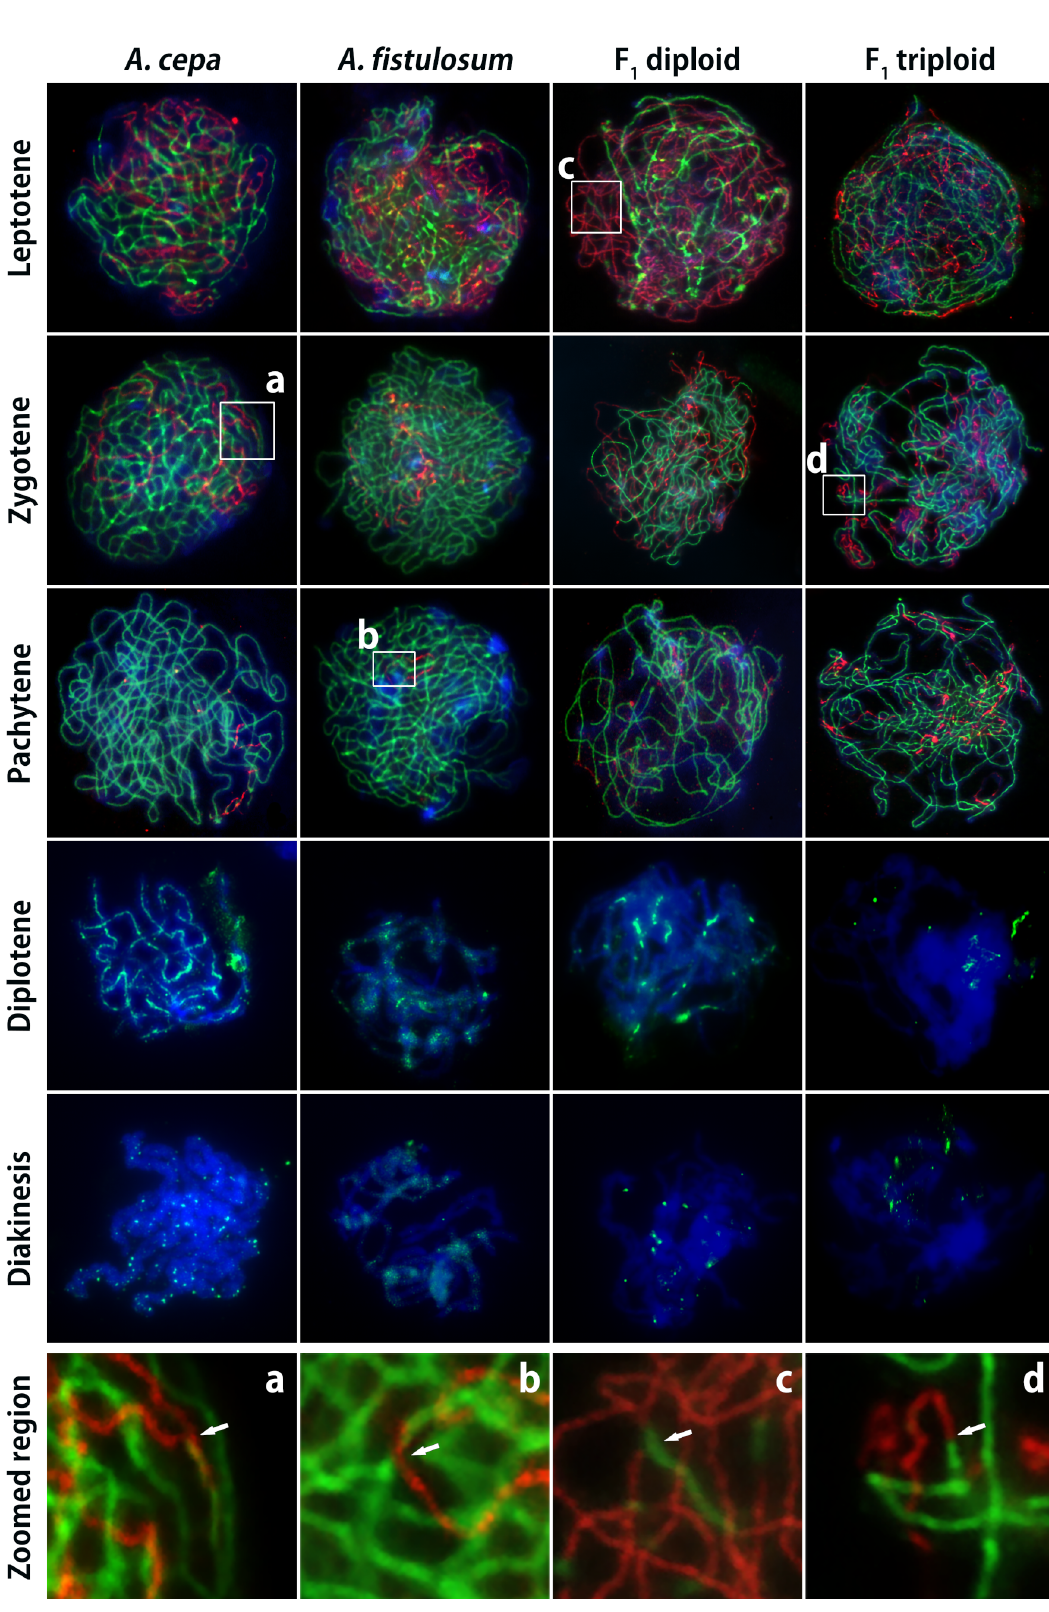
Figure 3. The behavior of ASY1 (red) and ZYP1 (green) during prophase I in A. cepa , A. fistulosum and their F 1 diploid and triploid hybrids. Chromatin was stained with DAPI. ( a – d ) Arrows in zoomed regions are pointing at regions with absence of the ASY1 signal after loading